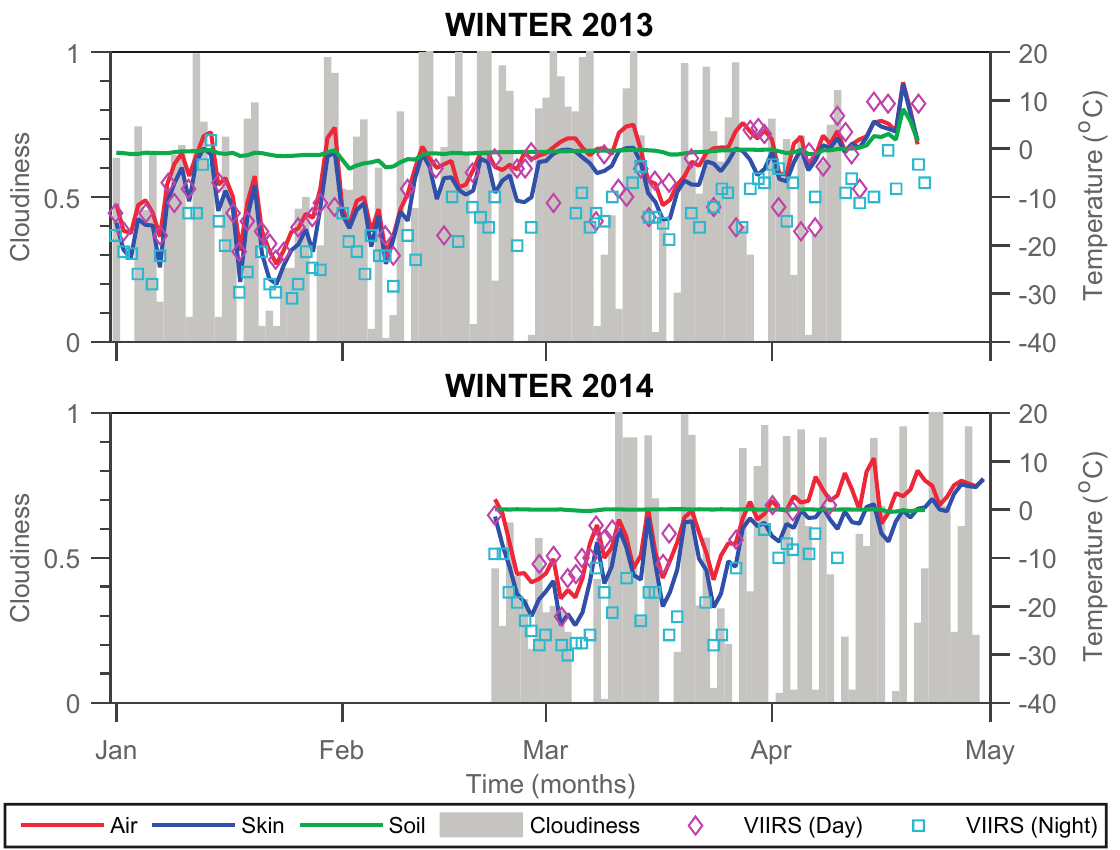
Figure 2. Daily T-skin, T-soil, T-air (at 2 m from soil surface), cloudiness, and VIIRS LST (daytime and nighttime overpasses) for the winters of 2013 and